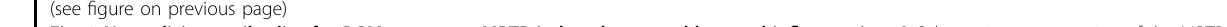
Fig. 2 Neutralizing antibodies for RGMa suppress MPTP-induced neuronal loss and in fl ammation. A Schematic representation of the MPTP injection and antibody treatment timeline. B , C Immuno fl uorescent staining for TH (green) in the SN of mice injected with saline or MPTP with anti- RGMa antibody or control IgG (cIgG) treatment from day 2 to day 15 ( B ) or from day 9 to day 21 ( C ) after the last MPTP injection. Scale bar, 200 μ m. D , E Stereology counts of TH-positive neurons in the SN of mice treated with anti-RGMa antibody or control IgG from day 2 to day 15 or from day 9 to day 21 after the last MPTP injection. n = 5 – 8 ( F ), n = 9 – 11 ( G ). * P < 0.05, ** P < 0.01, two-way ANOVA with Bonferroni multiple comparison test. F , G Immuno fl uorescent staining for Iba1 in the SN of mice injected with saline or MPTP with anti-RGMa antibody or control IgG treatment from day 2 to day 15 ( F ) or day 9 to day 21 ( G ) after the last MPTP injection. Scale bar, 100 μ m. H , I Stereology counts of Iba1-positive neurons in the SN of mice treated with anti-RGMa antibody or control IgG from day 2 to day 15 or from day 9 to day 21 after the last MPTP injection. n = 4 – 5 ( H ), n = 4 – 6 ( I ). * P < 0.05, ** P < 0.01, *** P < 0.005, two-way ANOVA with Bonferroni multiple comparison